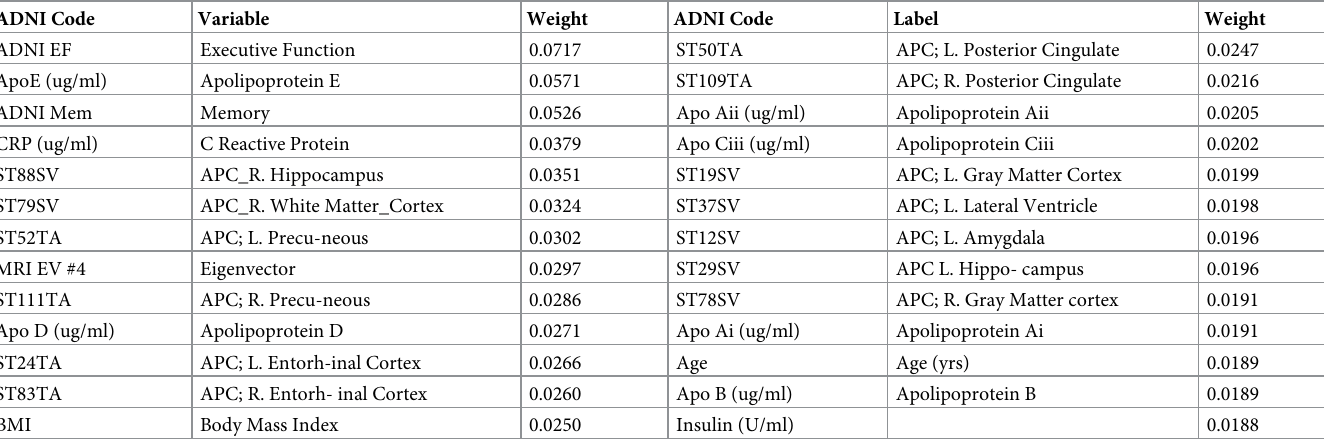
Table 3. GINI importance of features from plasma BMs, MRI, cognitive, atrophy rate & demographics. ADNI